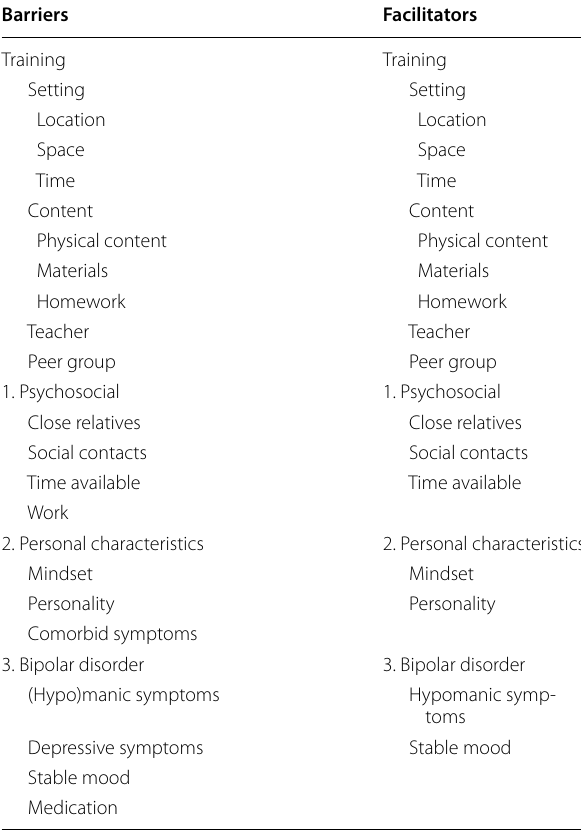
Table 2 Themes and subthemes of facilitators and barriers during MBCT